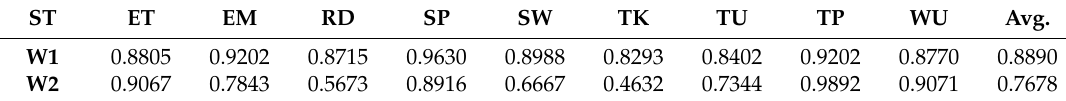
Table 8. F 1 accuracy of the standing group (ST). Table 8 . F1 accuracy of the standing group (ST). Table 8 . F1 accuracy of the standing group (ST).